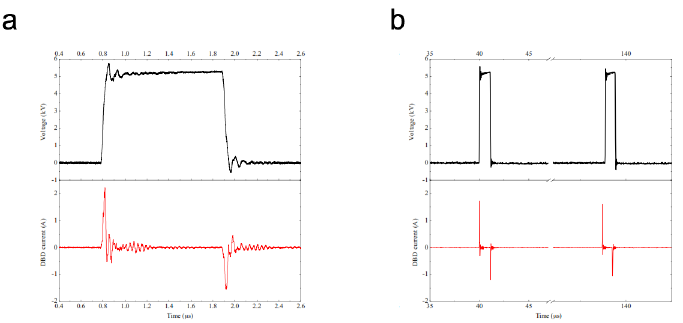
Fig 2. Electrical high voltage and current signals analyzed during one impulse (2a) and during one period (2b) (He gas flow = 2slm, voltage frequency = 10kHz, voltage amplitude = 5kV, voltage duty cycle =